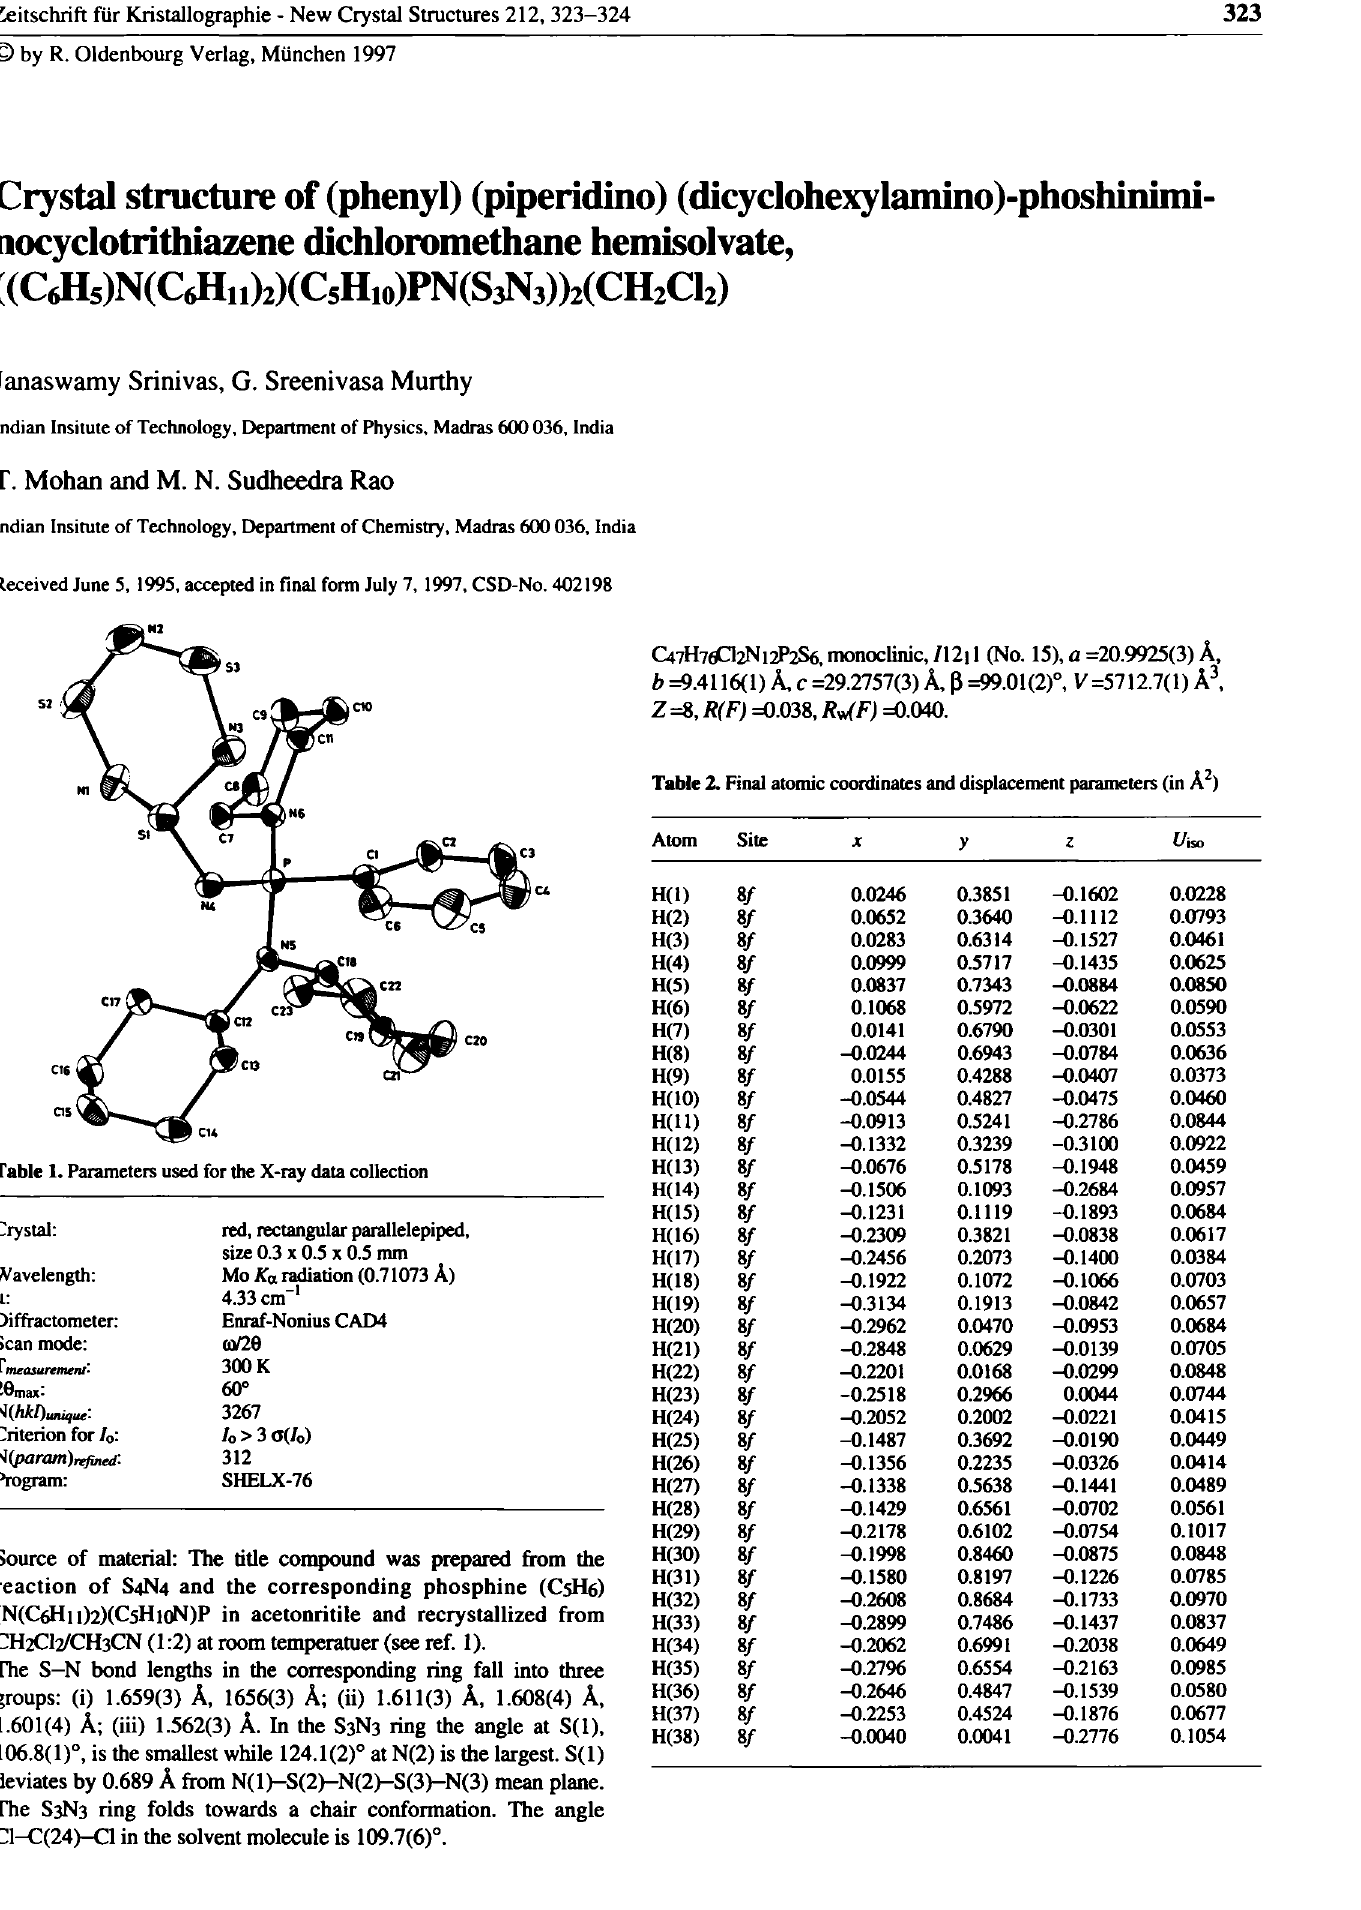
Table 2. Final atomic coordinates and displacement parameters (in Â 2